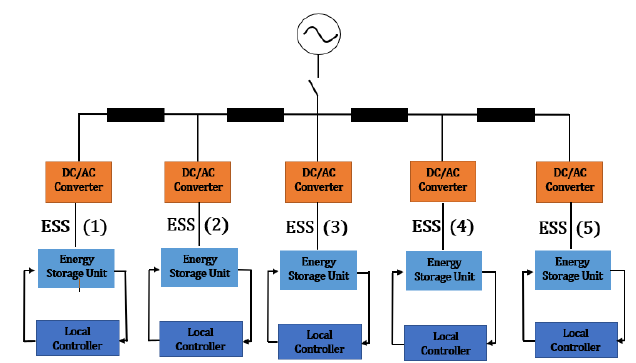
Figure 3. Decentralized control of AC microgrid.